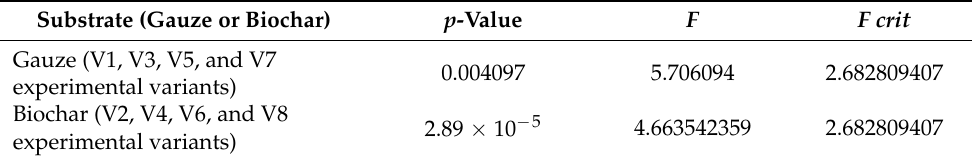
Table 3. A one-way ANOVA test for Lepidium sativum L. sprouts’ weight. Table 3. A one ‐ way ANOVA test for Lepidium sativum L. sprouts’ weight. Substrate (Gauze or